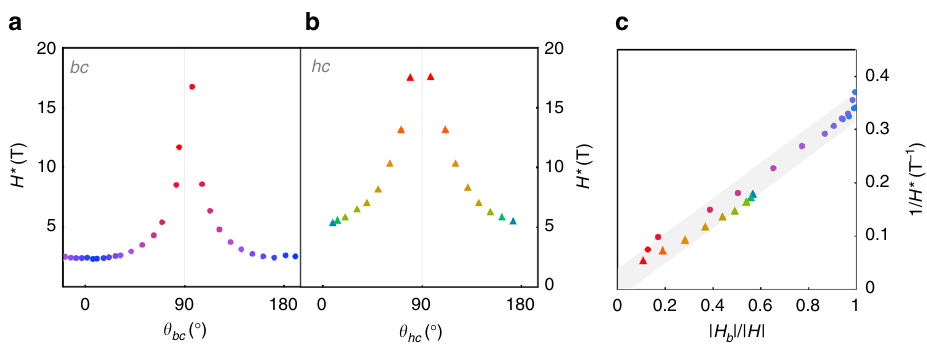
Fig. 2 Angle dependence of H * . a H * vs. rotation angle θ for both the bc - and b hc - rotational planes, with θ de fi ned as the angle between the ab -plane and the magnetic fi eld. c 1/ H * plotted vs. | H b | / | H | . The magnitude of 1/ H * collapses approximately to a straight line for fi eld rotation in both planes, illustrating that H * depends entirely on M b